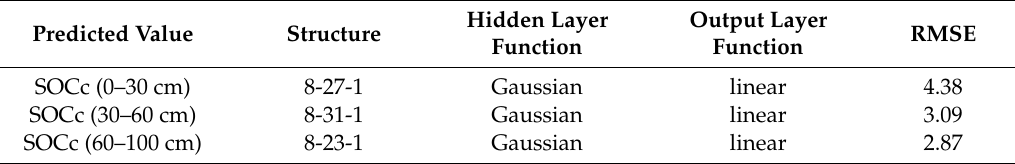
Table 3. Parameters of the optimal training ANN